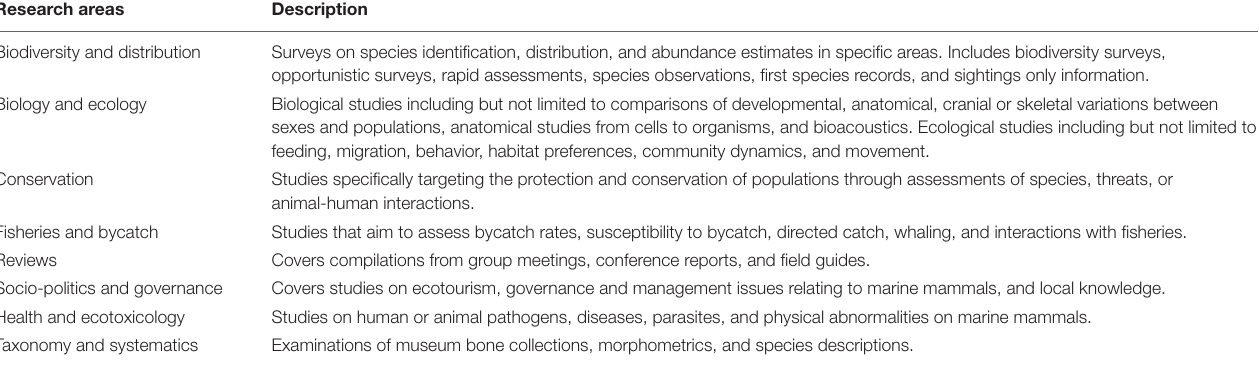
TABLE 1 | Different thematic areas of research on marine mammals in the Philippines identified for the purpose of this